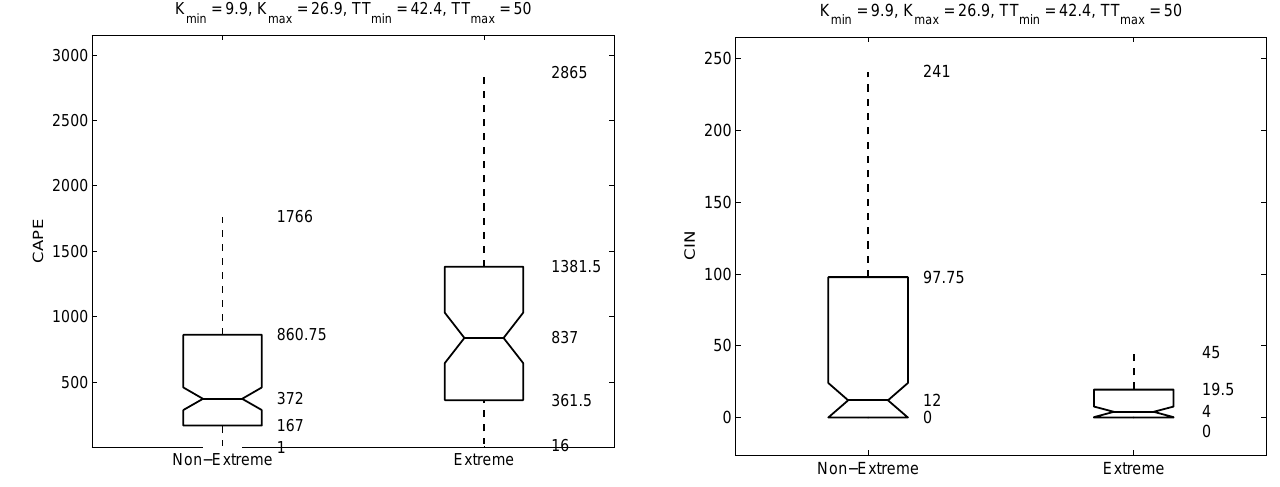
Fig. 4. The distribution of the values of the DCAPE index for the days where extreme (right) and non-extreme (left) events occurred.